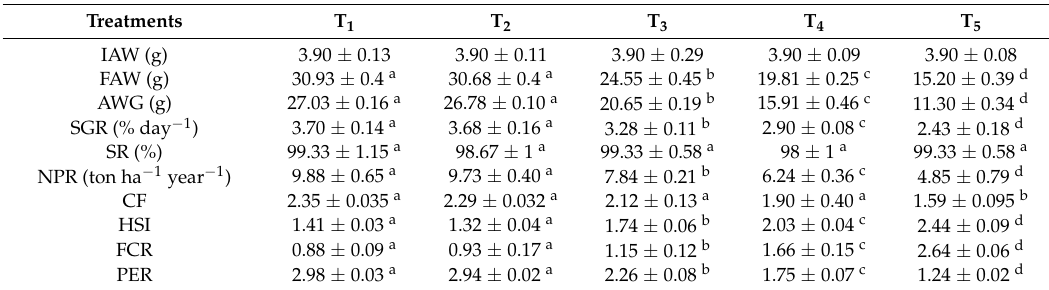
Table 2. Growth performance of Thai silver barb Barbonymus gonionotus fed varying compositions of A. pinnata and commercial fish feed after 56 days.